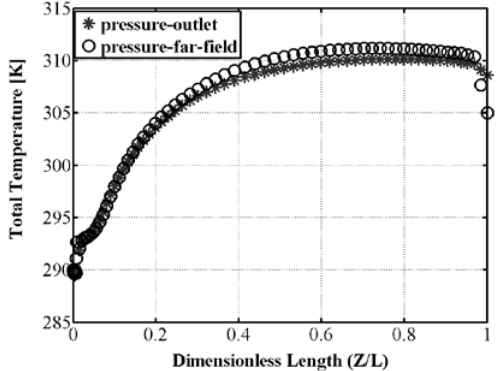
Fig. 11. Comparison of the total pressures at different longitudinal sections regarding two different boundary conditions